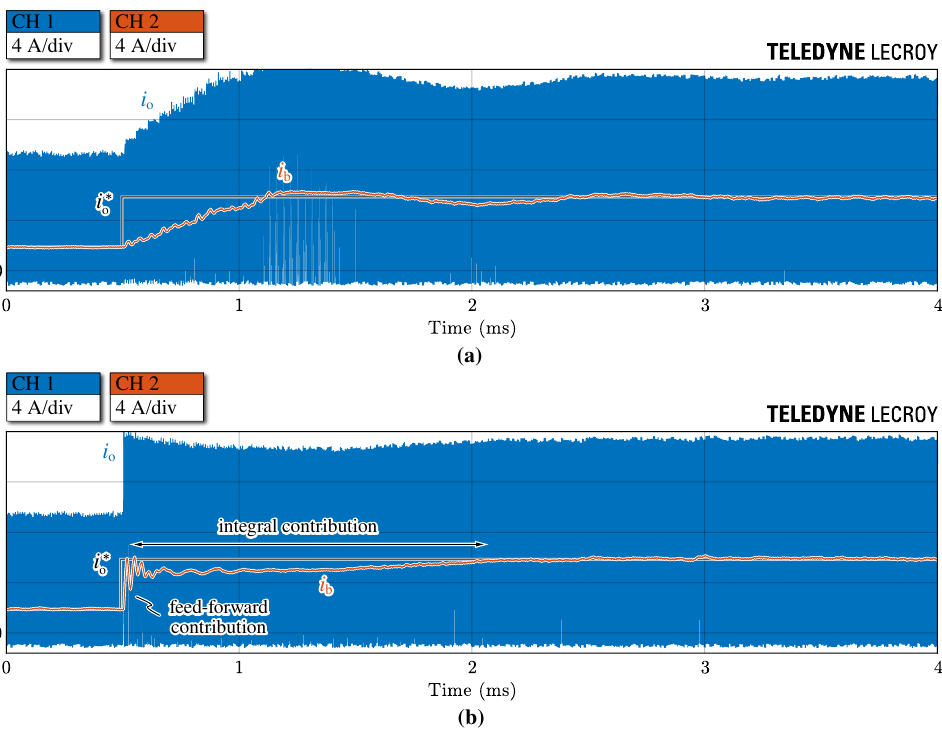
Figure 19. Experimental output current ( i o ) response to a reference step from 2A ( P = 800W) to 6A ( P = 2400W) with V b = 400V: ( a ) only integral controller, ( b ) feed-forward + integral